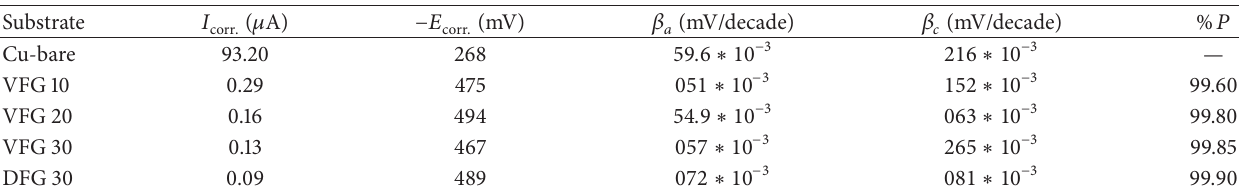
Table 2: Electrochemical parameters obtained from potentiodynamic polarization of uncoated and coated copper alloy with superhydropho- bic FG.